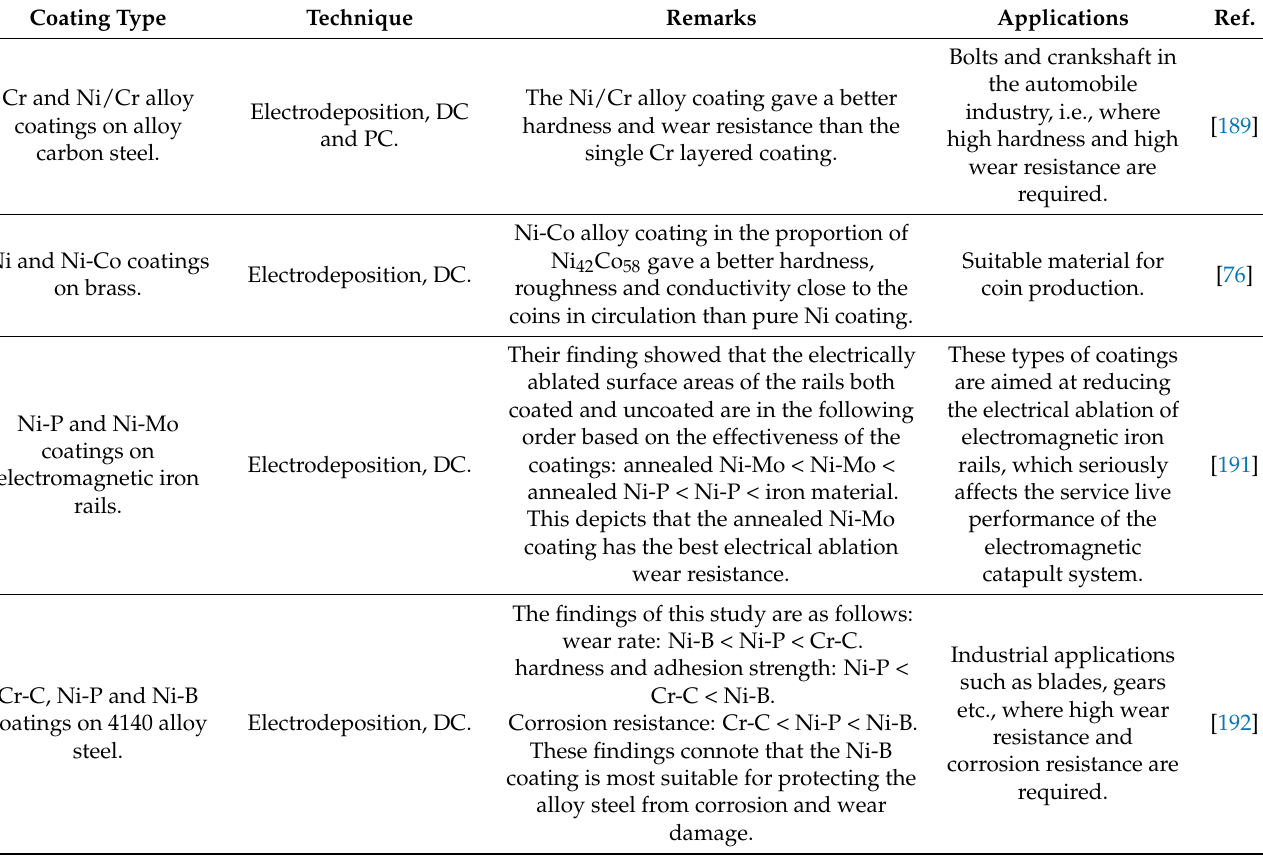
Table 3. A summary of previous studies showing different binary alloys of Cr and/or Ni coatings and their